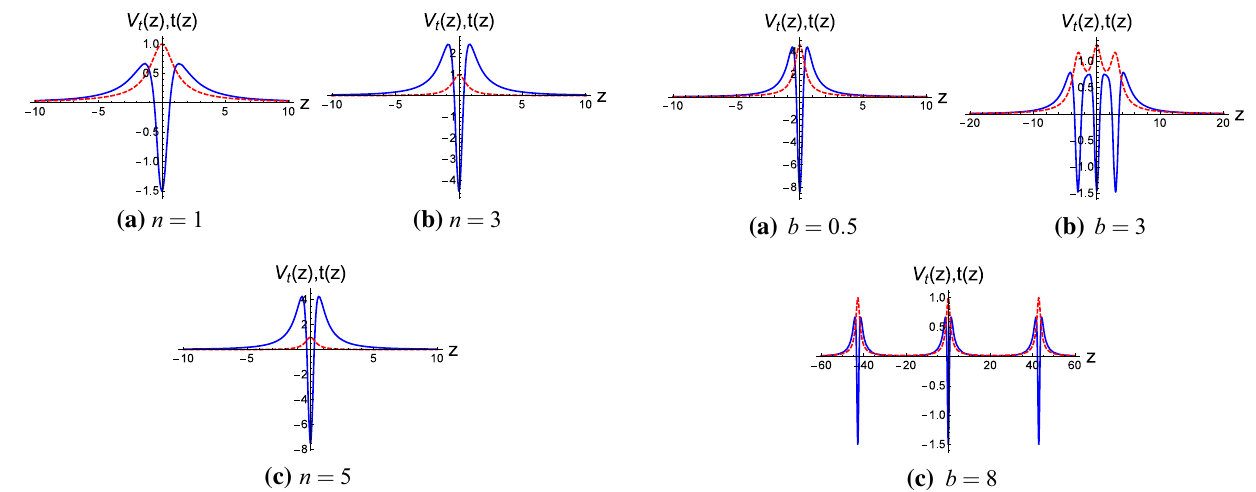
Fig. 3 a n = 1, b n = 3, c n = 5 The effective potential V t ( z ) (blue solid lines) and the zero mode t 0 ( z ) (red dashed lines) of the tensor perturbation for brane model 1. The parameters are set k = 1, and n = 1 in a , n = 3 in b , n = 5 in c